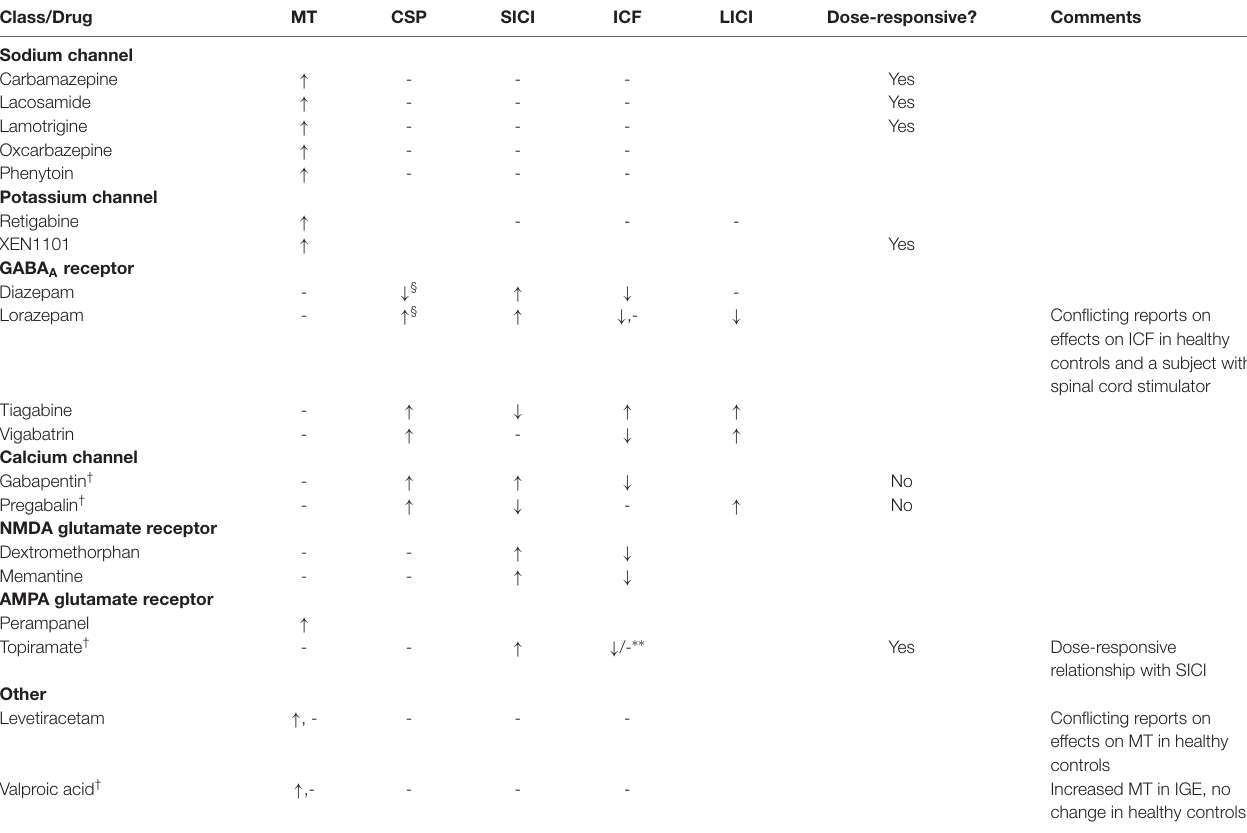
TABLE 2 | Antiepileptic drug effect on TMS parameters. Class/Drug